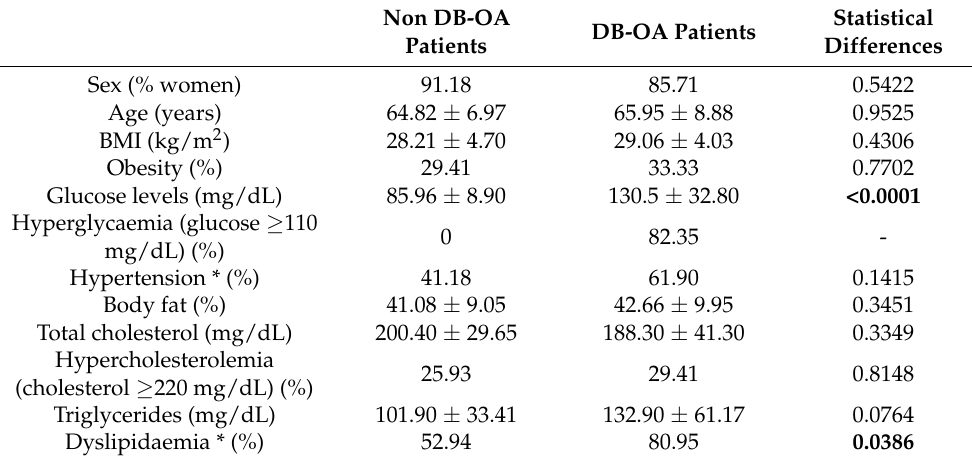
Figure 1. Serum H 2 S levels in osteoarthritic patients with or without diabetes. Using an ion-selective microelectrode, ( a ) the levels of H 2 S were measured in the sera from osteoarthritis patients without diabetes (non DB-OA, blue dots; n = 34) or with diabetes (DB-OA, green dots; n = 21). Additionally, the study population was divided into patients with normoglycaemia (n = 29) or hyperglycaemia (n = 14) ( b ) or individuals with normolipidaemia (n = 20) or dyslipidaemia (n = 35) background ( c ) and H 2 S levels were analysed in these subsets of patients. Values are mean ± SEM. * p ≤ 0.05 analysed by the Mann–Whitney test. Table 2. Socio-demographic and clinical characteristics of serum donors. Columns in the middle show means of values ± SEM or percentage of population per each socio-demographic or clinical variable. Column on the right indicates the p-value obtained in the statistical test for a comparison of values for each variable between non DB-OA (n = 34) and DB-OA (n = 21) patients ( p ≤ 0.05 shown in bold font, analysed by the Mann–Whitney test). * History of hypertension/dyslipidaemia (altered blood cholesterol and/or triglyceride levels).